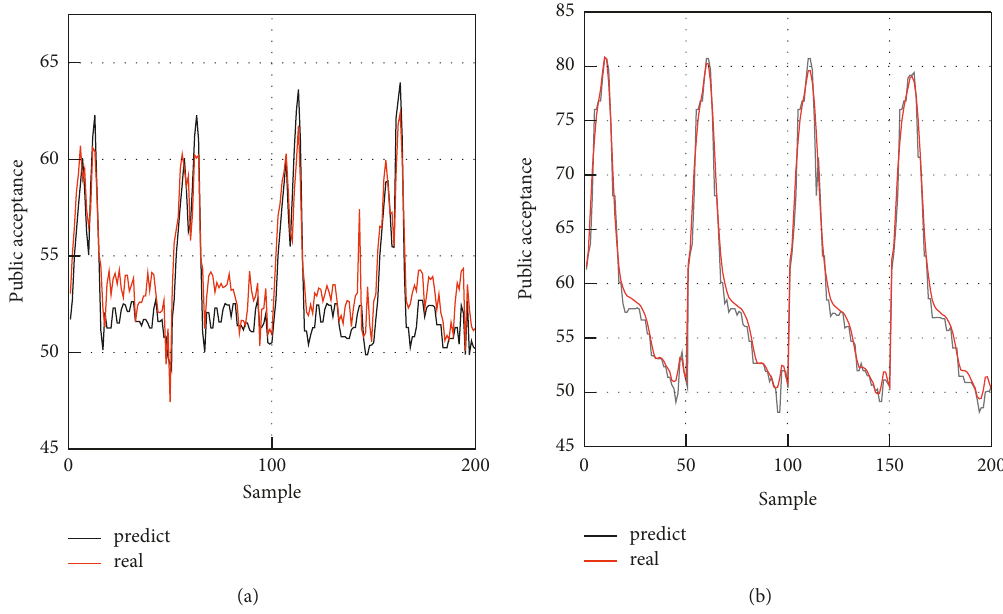
Figure 8: Comparison of the predicted and real public acceptance in two provinces: (a) province � “ P 1”; (b) province � “ P 2.”